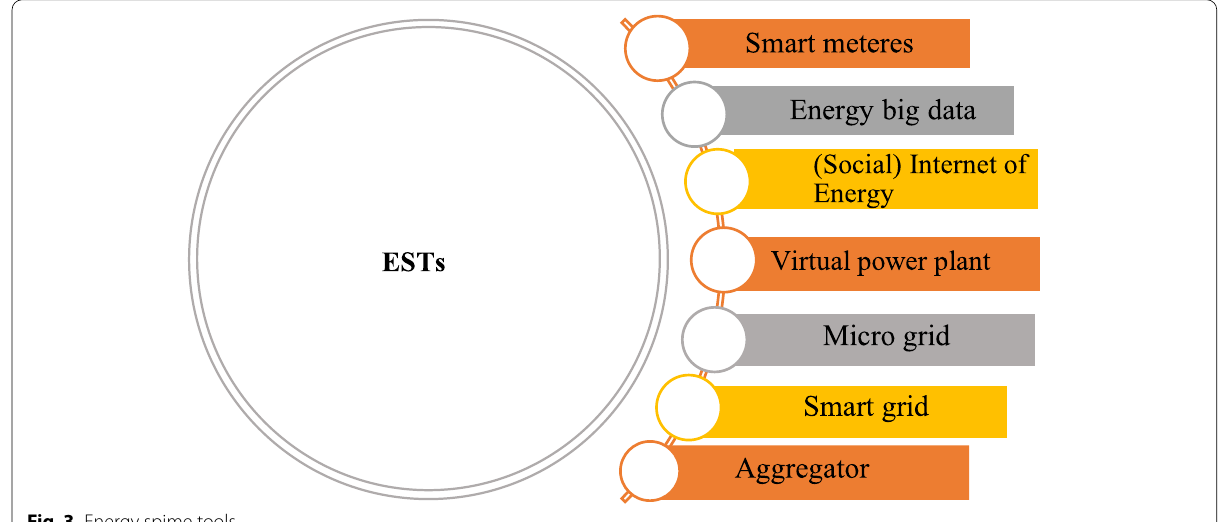
Fig. 3 Energy spime